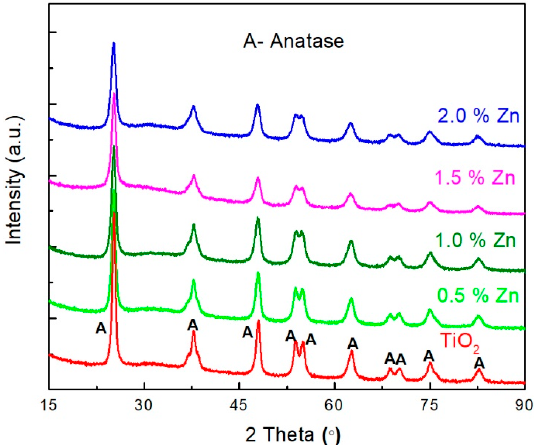
Figure 1. X-Ray Diffraction (XRD) patterns of the undoped and Zn-doped TiO 2 nanomaterials. The average crystalline size of the synthesized nanomaterials was estimated by Debye–Scherrer equation using the predominant anatase (101) plane.